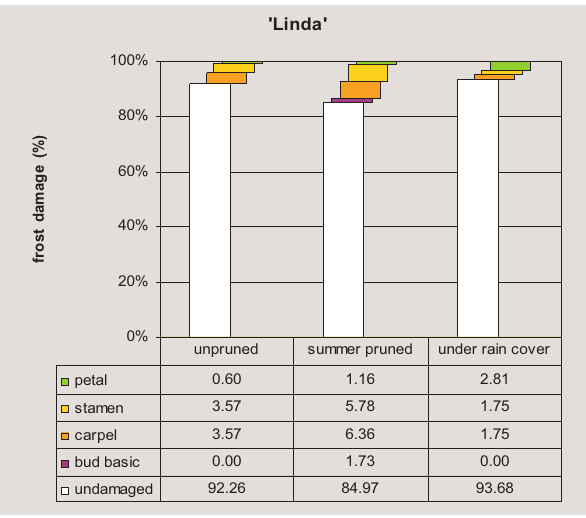
2011 as an effect of different pruning methods performed during 2010